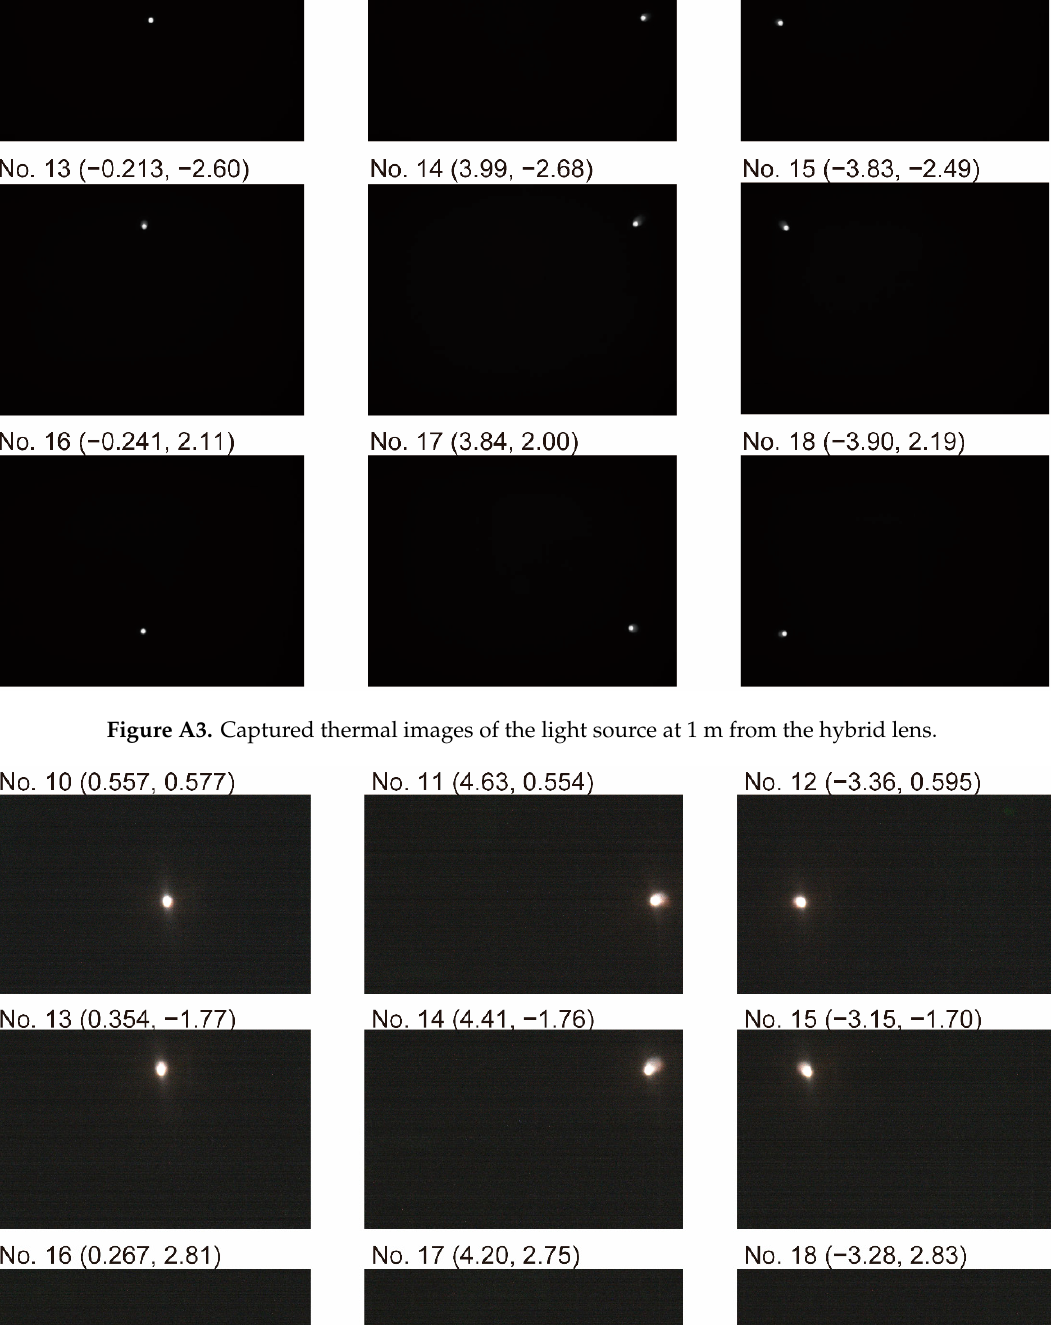
Figure A2. Captured color images of the light source at 0.5 m from the hybrid lens.